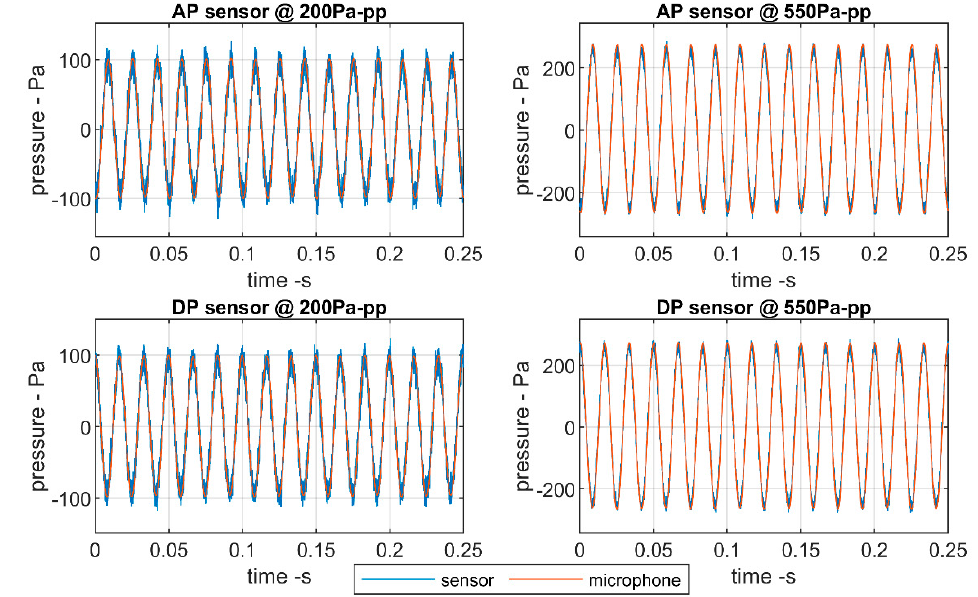
Figure 6. Detail of the comparisons between the sine wave signals of the low-cost sensors and the high-fidelity microphone.